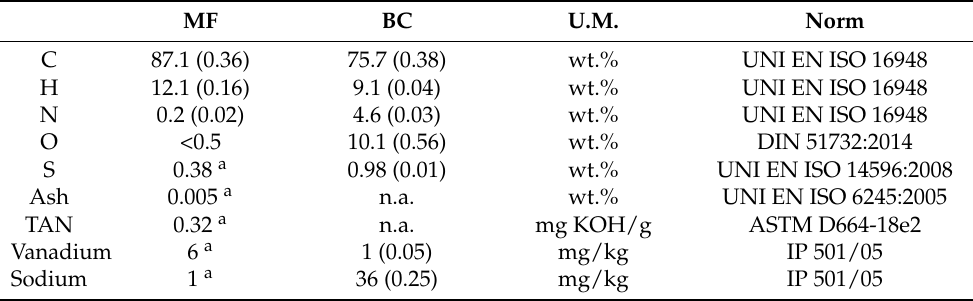
Table 1. Chemical characteristics of MF and SS biocrude. Standard deviations, where available, are reported in